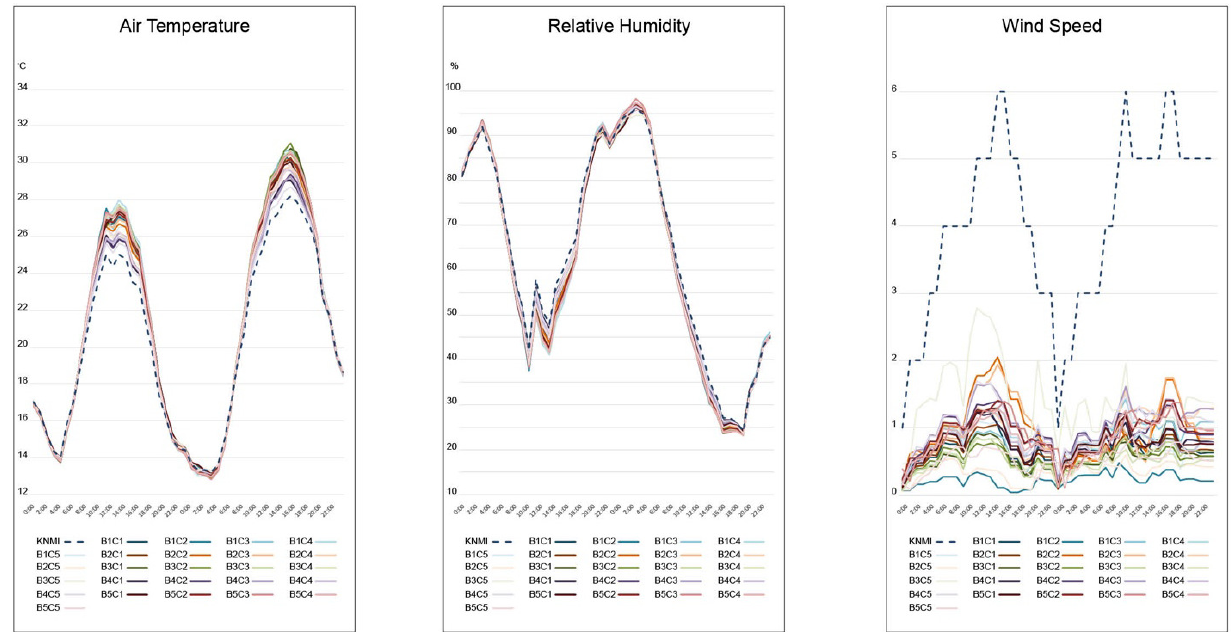
Figure 6. Building average air temperature (left), relative humidity (centre), and wind speed (right) near